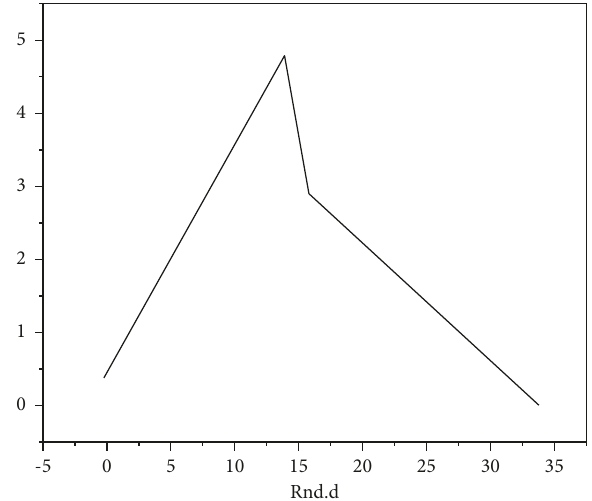
Figure 4: Comparison of vibration reduction performances of TMDI and TMD systems under seismic acceleration.